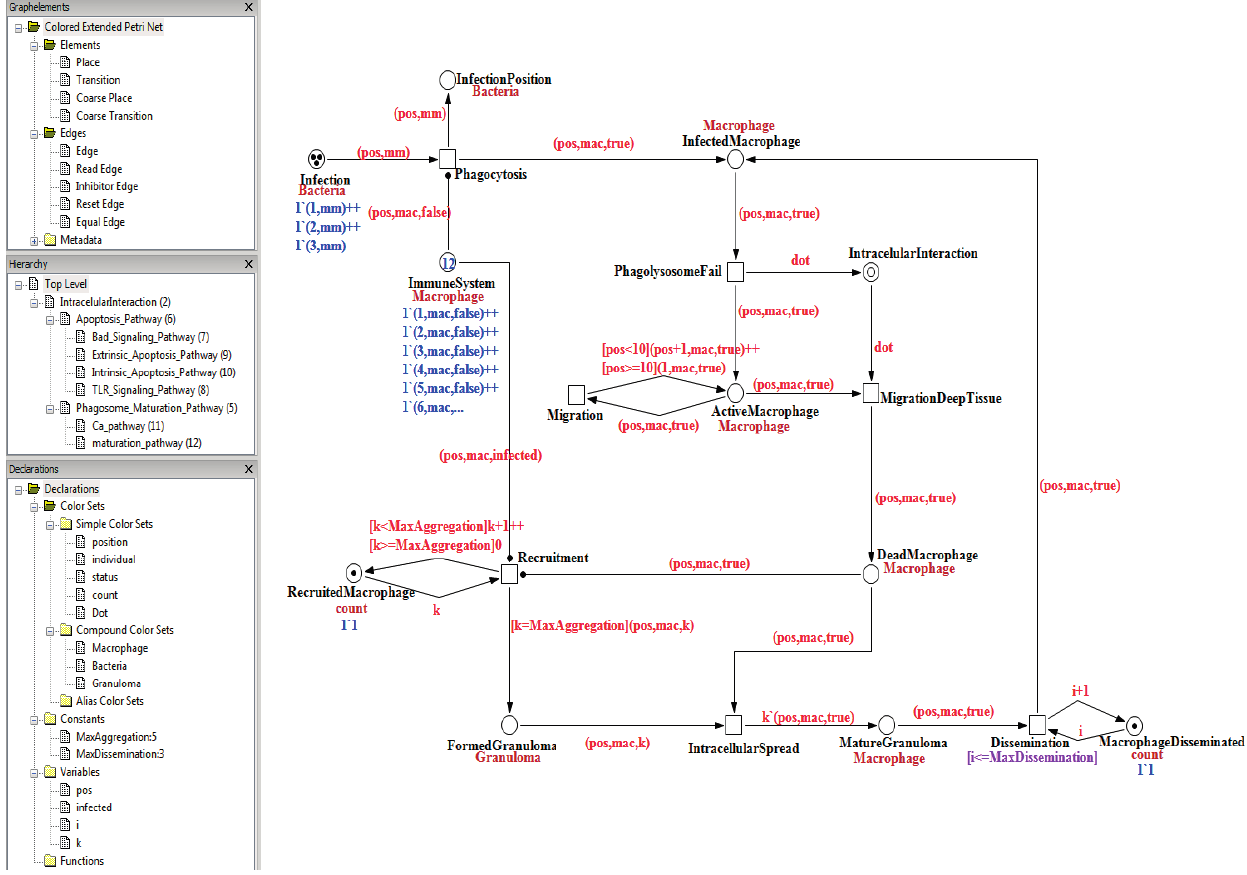
Figure 4. Visualization of the qualitative colored Petri net model implemented in the Snoopy framework [44]. In the left panel, information about the Petri net model is displayed: the hierarchical structure and definitions used in the model, the color-set, the constants, and variables. The main panel shows level 1 (cf . Top Level) of the hierarchical Petri net model and its